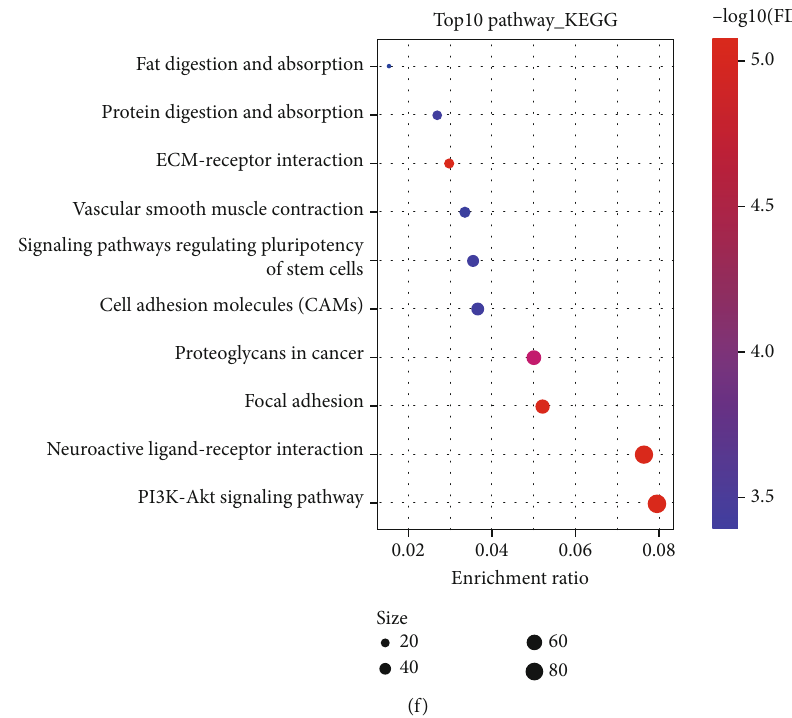
Figure 10: (a) Correlation analysis of the LDA score and metabolic characteristic index. (b) Prognostic correlation of modules related to the immune characteristic index. Log-rank test was conducted. (c) Functional enrichment analysis of brown module